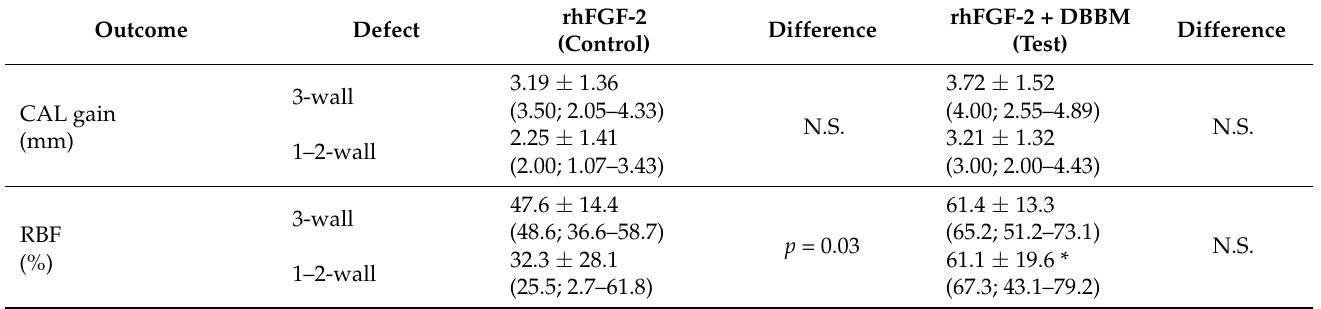
Table 3. Comparison of clinical attachment level (CAL) gain and radiographic bone fill (RBF) at 4 years postoperatively between different defect